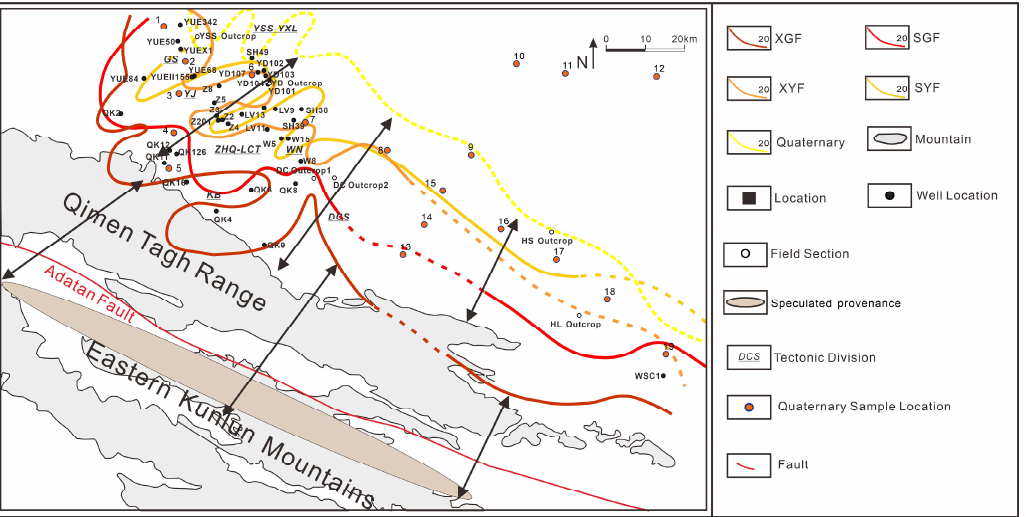
Figure 9. ZTR = 20 contour of heavy minerals in Cenozoic and the reconstruction of southwestern boundary of Qaidam Basin. Note that the position of the mountain in the picture is the location of the present Qimen Tagh Range and Eastern Kunlun Mountains.